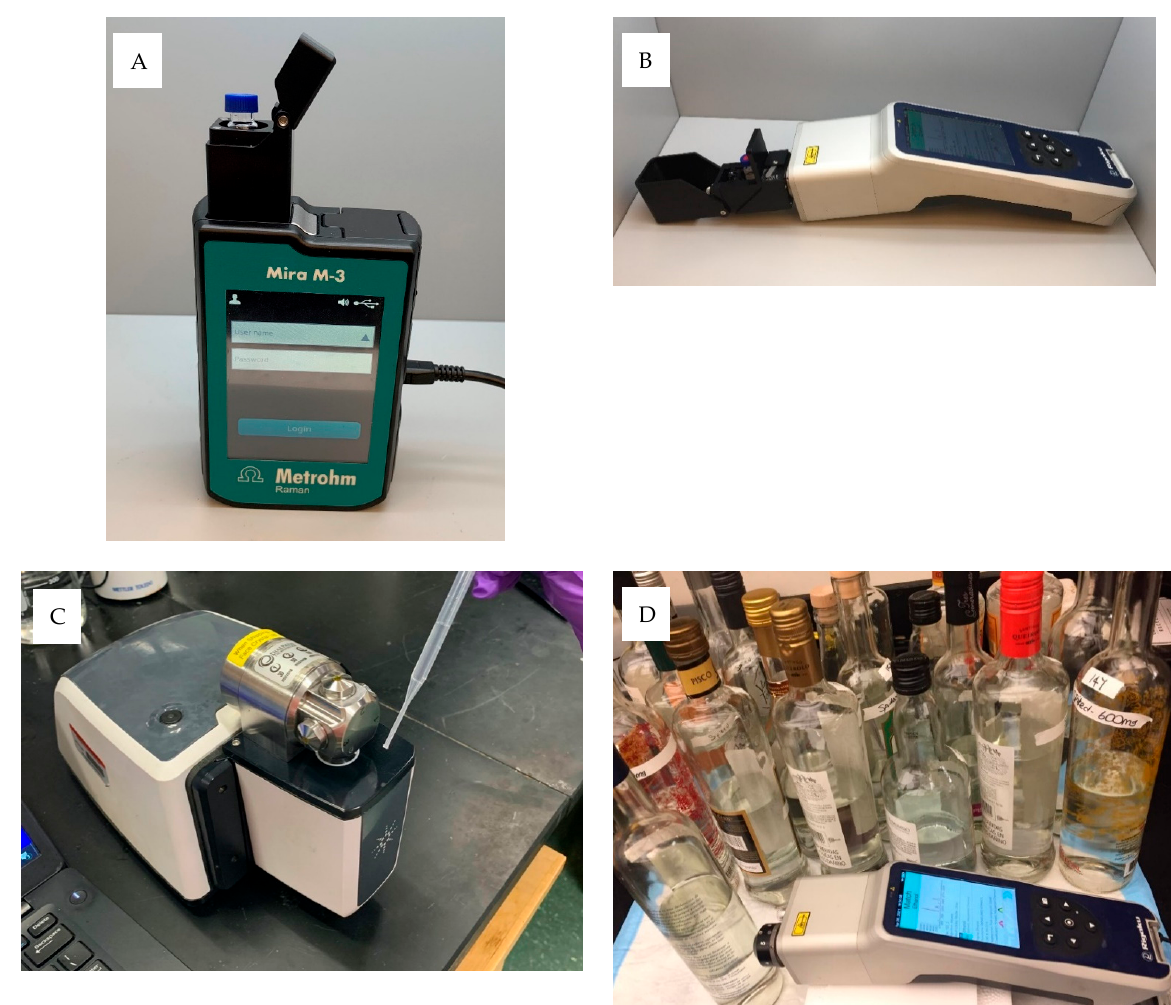
Figure 1. Vibrational spectroscopy units used in this research. ( A ) Metrohm Mira M3 (785 nm) Raman instrument, ( B ) handheld Progeny Rigaku (1064 nm), ( C ) portable Agilent Cary 630 FT-IR device, and ( D ) handheld Progeny Rigaku (1064 nm) instrument conducting the through-the-bottle analysis.